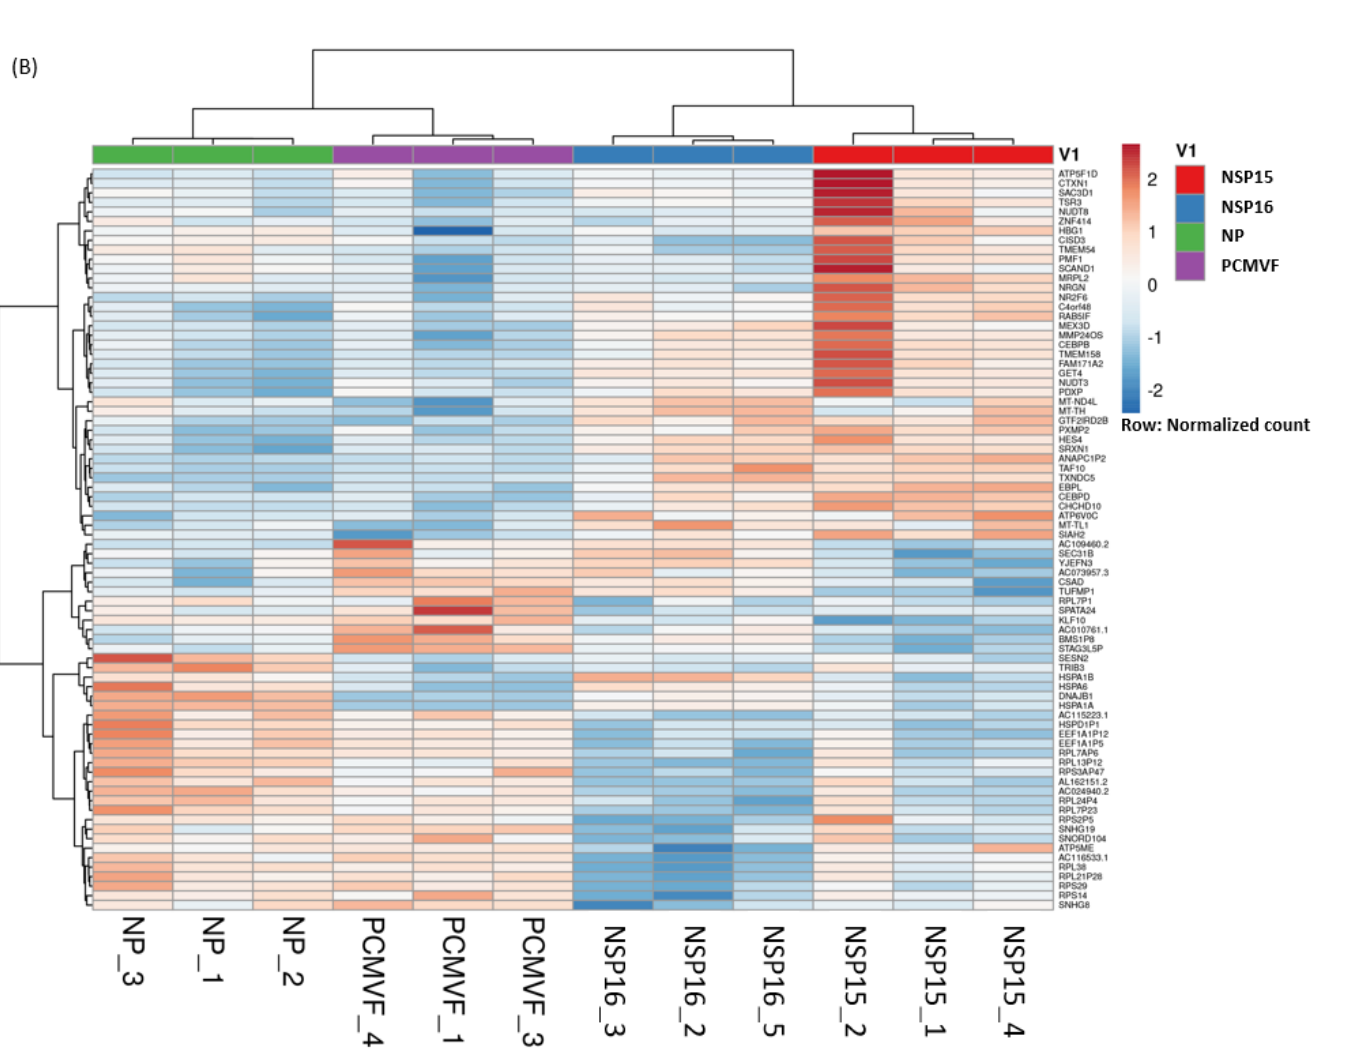
Figure 2. Heatmap across all the analyzed samples illustrating significant DEGs (log2 FC > 0.32, padj < 0.05) of HL-CZ cells transfected with ( A ) SARS-CoV-2 S1 and S2 versus PCMV vector control, and ( B ) SARS-CoV-2 NSP15, NSP16, NP versus PCMVF vector control. As illustrated in Figure 3A, HSPA1B, HSPA1A, HSPA5, CRELD2, and HERPUD1 were the five most significantly elevated genes in S1-transfected cells. Similarly, in the S2- transfected cells, HSPA1B and HSPA1A were found to be the most significantly elevated genes (Figure 3B). In NSP15-transfected cells, CHCHD10, TAF10, CEBPD, TMEM158, TSR3 and EBPL were the most significantly increased transcripts, while the most signifi- cantly down-regulated genes were KLF10 and HBG1 (Figure 3D). In NSP16-transfected cells, RPL38, RPS29, RPS14, ATP5ME, and RPL21P28 were the most significantly de- creased genes, while HSPA1B, CHCHD10, HSPA1A, and TAF10 were the most signifi- cantly elevated (Figure 3E). In NP-transfected cells, DNAJB1, HSPA1A, SESN2, and TRIB3 exhibited the most significantly increased transcript levels (Figure 3F). Comparisons of volcano plots between cells transfected with S1, S2, NSP15, NSP16 and NP are also illus- trated in Figure 3C,G,H,I.